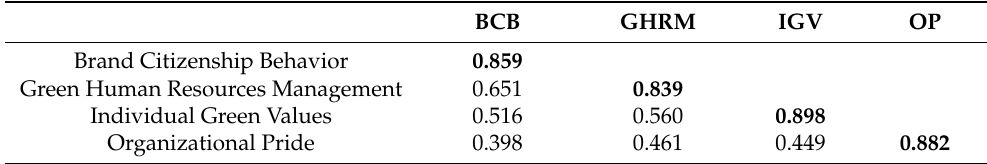
Table 3. Fornell–Larcker criterion matrix.